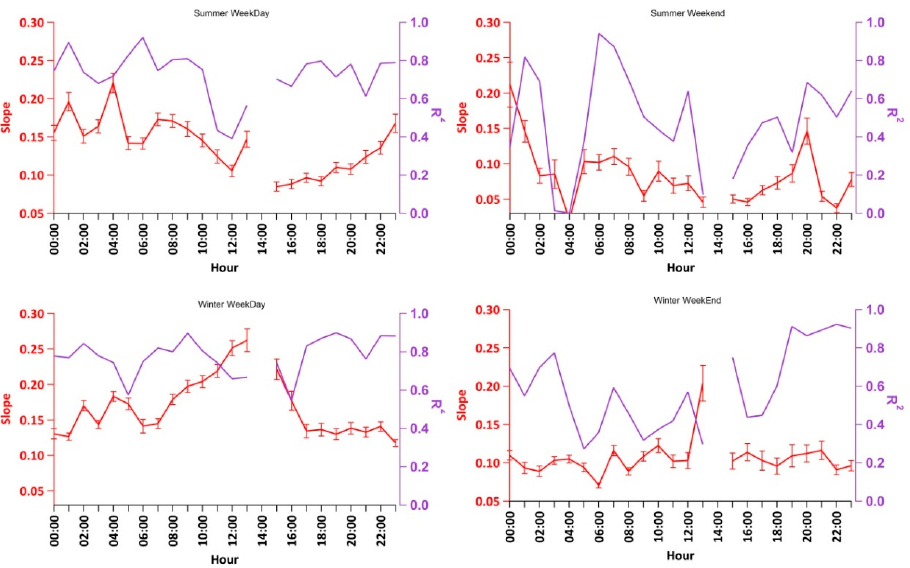
Figure 7. The Slope and r 2 value from the regression (WODR) between NO x and CO varied with the hour-of-day, for weekdays and weekends during summer (top panel) and winter (lower panel). Data is missing at 14:00 due to daily instrument